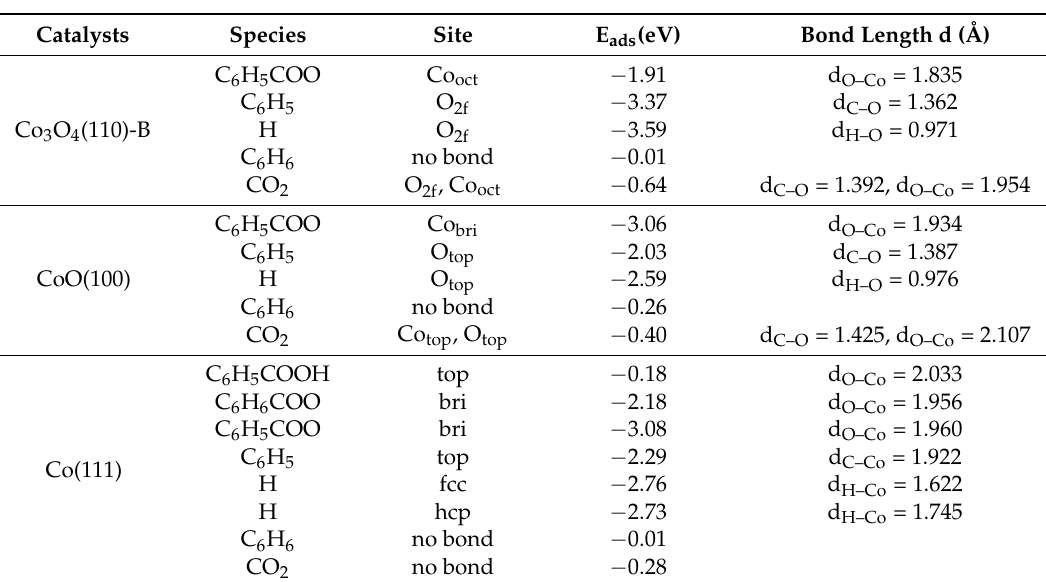
Figure 3. Structures of the possible intermediates of C 6 H 5 COOH pyrolysis on ( a )Co 3 O 4 (110)-B, ( b )CoO(100) and ( c )Co(111) surfaces. Table 1. Adsorption energies and geometrical parameters of relevant species on Co 3 O 4 (110)-B, CoO(100) and Co(111) surfaces.